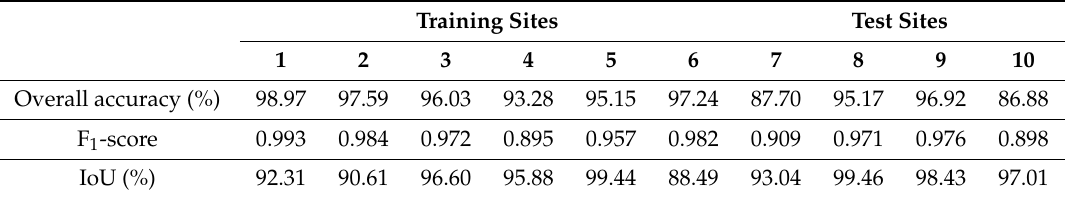
Table 2. Accuracy assessment of building